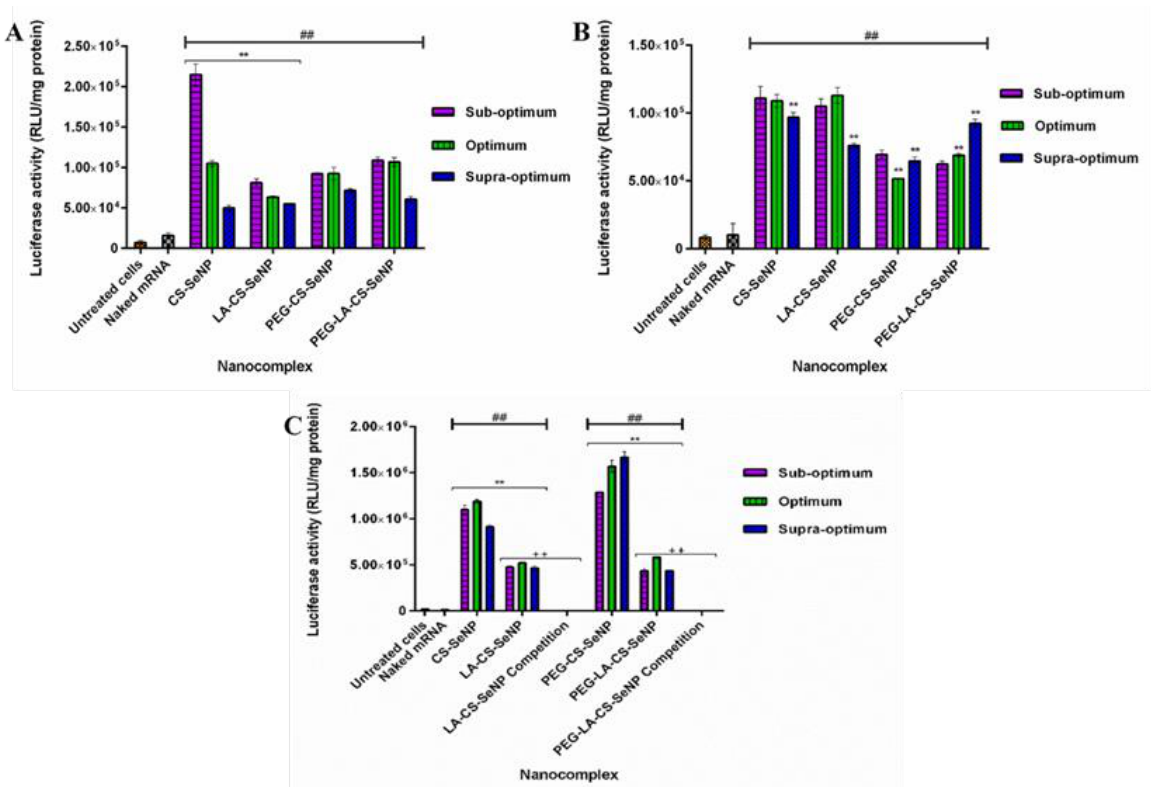
Figure 9. In vitro transfection potential of FSeNP nanocomplexes in the ( A ) HEK293, ( B ) Caco-2, and ( C ) HepG2 cells. An untreated cells control and a naked mRNA control were included. Column data are represented as mean ± SD ( n = 3): ## p < 0.01 showing statistical significance between respective nanocomplexes vs. control 2 (naked mRNA), ** p < 0.01 showing a statistical significance between similar ratios of targeted vs untargeted nanocomplexes, ++ p < 0.01 showing a statistical significance between similar ratios of targeted vs untargeted nanocomplexes after blocking of the ASGPR. Statistical significance was calculated using two-way ANOVA.